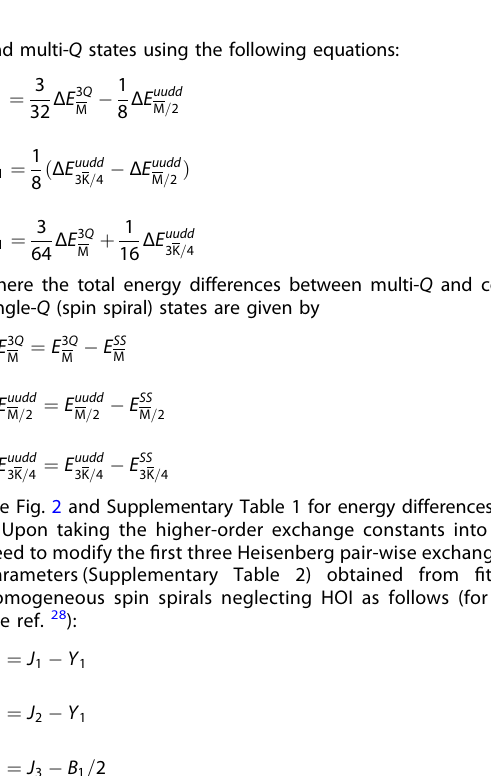
Fig. 6 Formation and spin structures of the multi- Q states. a Superposition of two 90 ∘ spin spirals (1 Q states) with clockwise (CW) and counterclockwise (CCW) rotational sense results in an uudd state (2 Q state). b 2D Brillouin zone of hexagonal lattice and reciprocal vectors b 1 and b 2 . Two high-symmetry directions Γ K and Γ M are shown. The q vectors corresponding to the uudd state along Γ K (green circle) and along Γ M (blue circle) as well as the 3 Q state at the M point (red circle) are shown. c Spin structure of the uudd state along Γ K , which is formed by a superposition of two 90 ∘ spin spirals at q = ± ð 3 = 4 Þ Γ K , d spin structure of the uudd state along Γ M , which is formed by a superposition of two 90 ∘ spin spirals at q = ± ð 1 = 2 Þ Γ M and e spin structure of the 3 Q state, which is formed by a superpostion of three spin spirals at the M point. Note that the spin structure of the uudd states is collinear, whereas it is non-collinear for the 3 Q